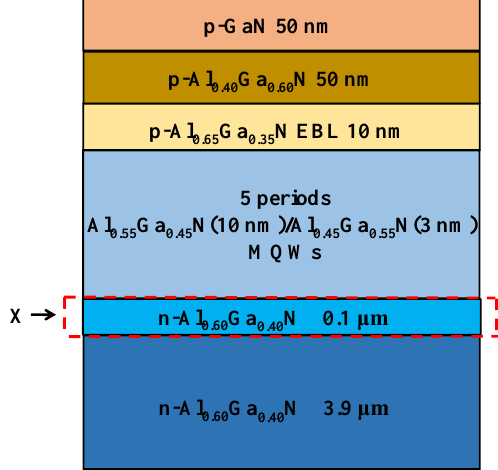
Figure 1. Schematic architectural diagram for structures with different Si doping concentration in the n-Al 0.60 Ga 0.40 N layer.